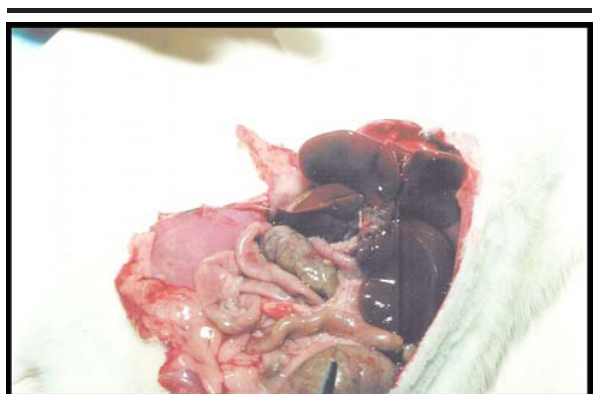
FIGURE 3 - Picture of animal in the experiment group with exposed viscera during the